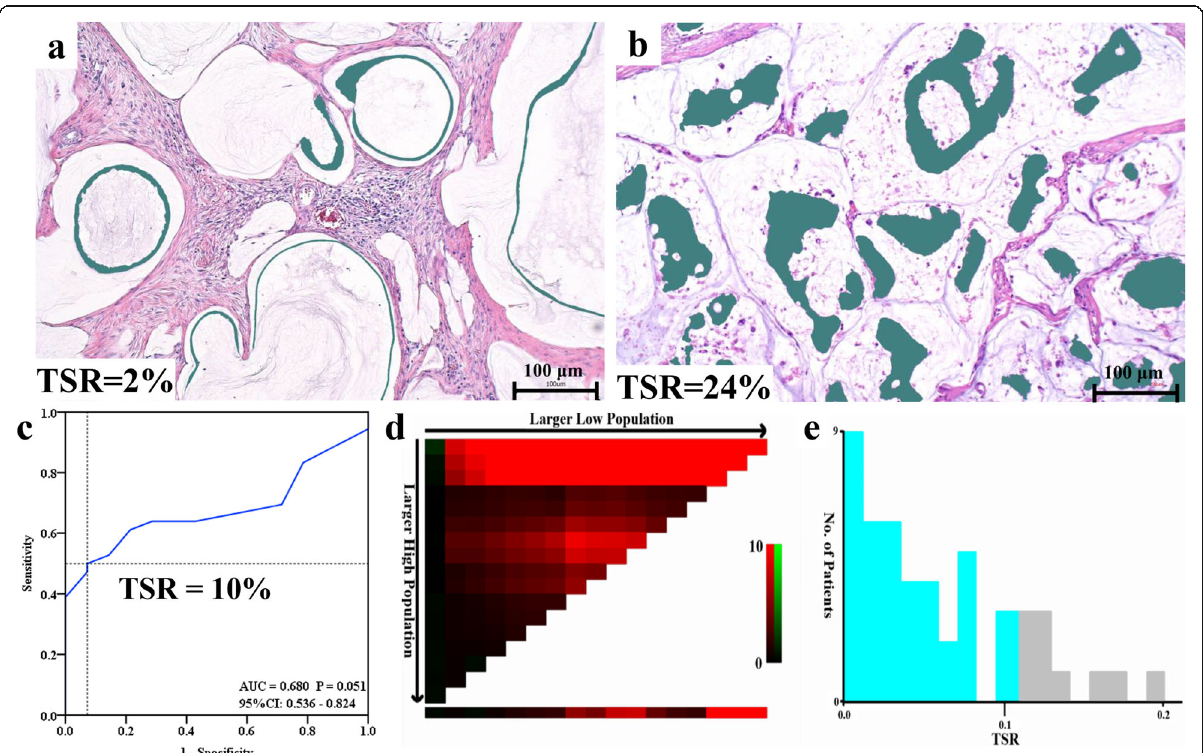
Fig. 2 The description of TSR. A The pathological image of patient with minimum TSR of 2%; B The pathological image of patient with maximum TSR of 24% (A, B: HE staining, ×100); C ROC curve of TSR of 50 patients. The dotted line indicated that TSR of 10% was the best cutoff value with high sensitivity and specificity; D, E : The cutoff value of TSR obtained by X-Tile software. TSR: Tumor-stroma ratio; HE: Hematoxylin